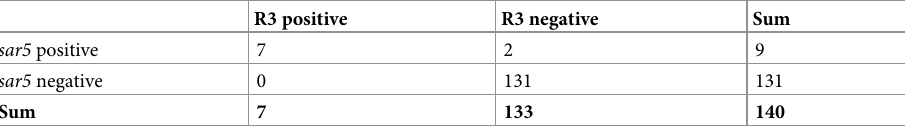
Table 2. Distribution of the sar5 gene and R3 expression among 140 GBS clinical